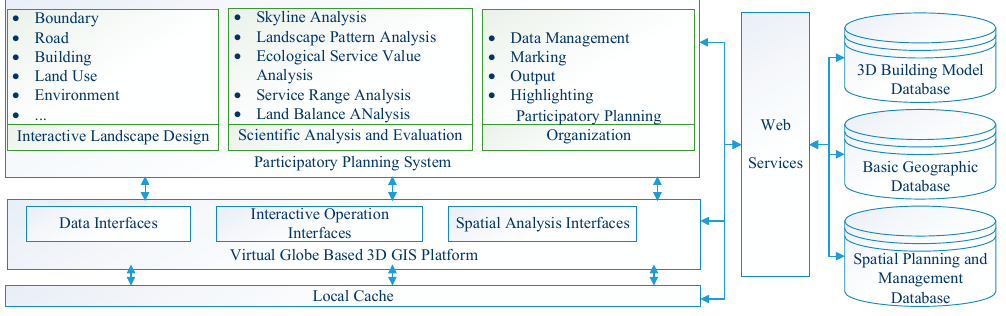
Figure 3. The system architecture of the virtual globe-based 3D PGIS for rural spatial planning.